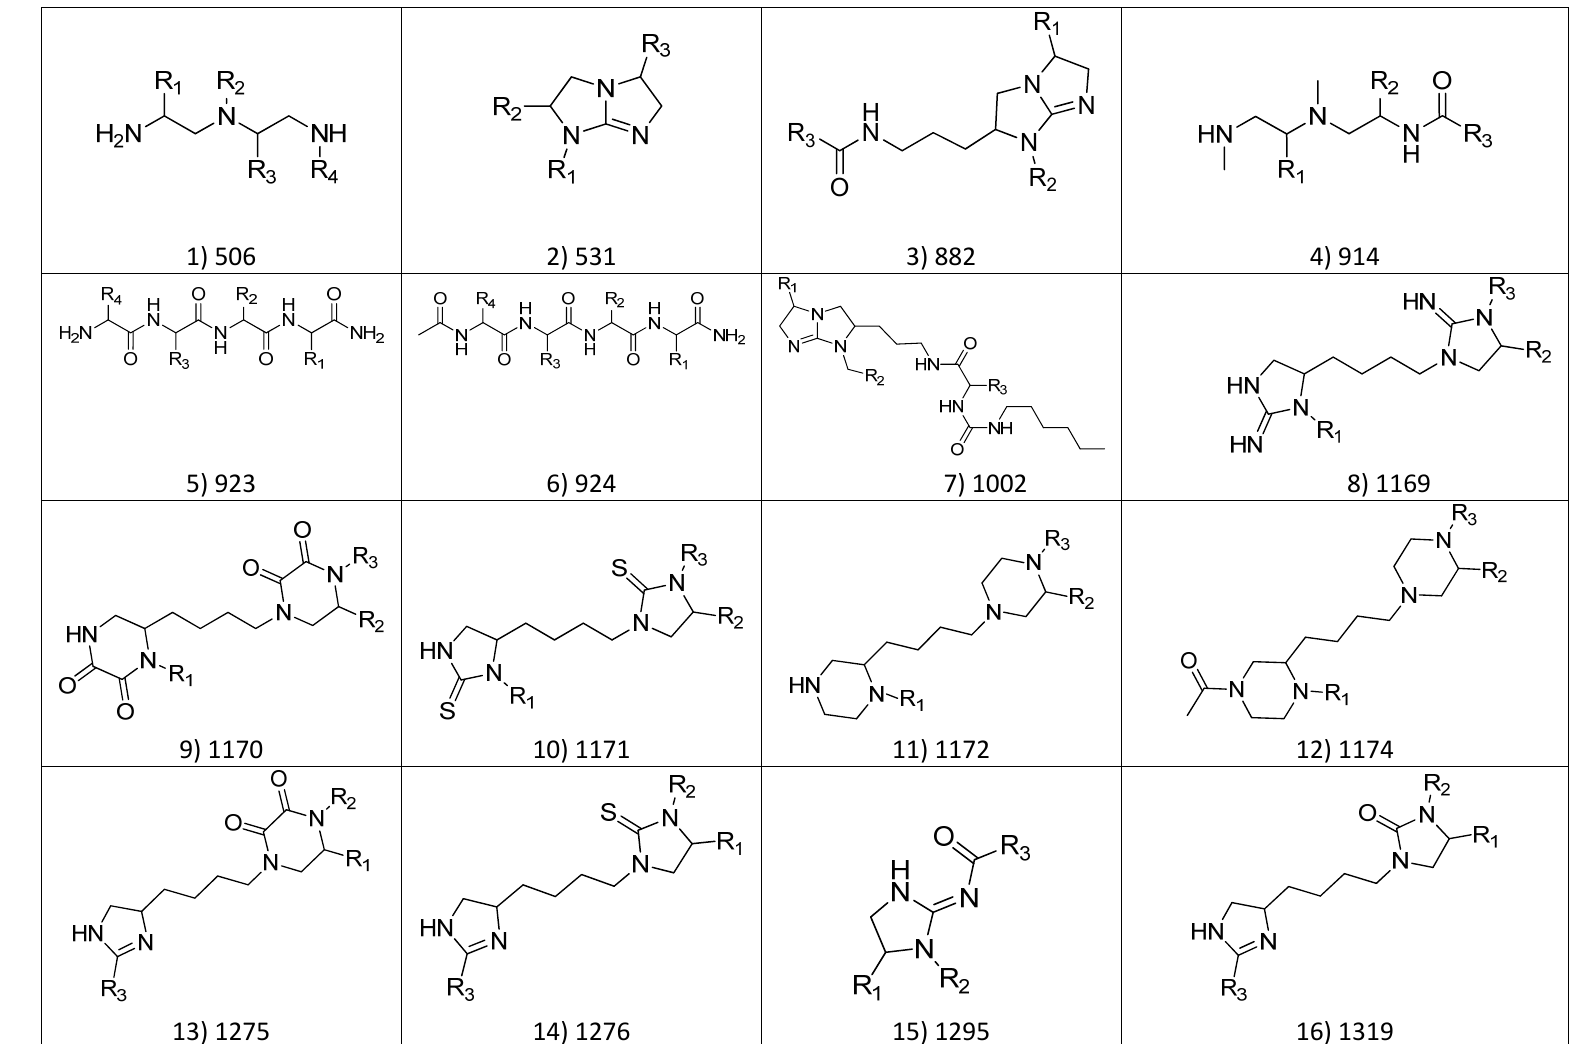
Figure 2. Thirty two small-molecule libraries tested against FPR1 and